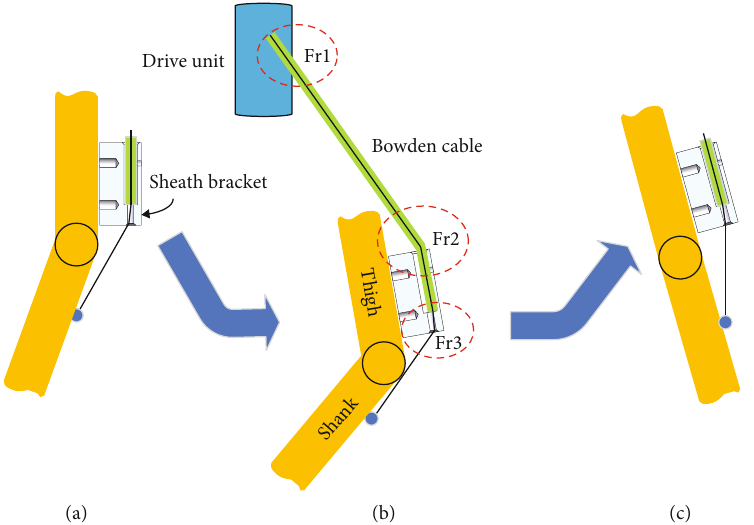
Figure 2: The swinging phase and friction locations of Bowden cable. (a) The beginning position of the swing phase. (b) The ultimate state of the swing phase. (c) The end position of the swing phase.